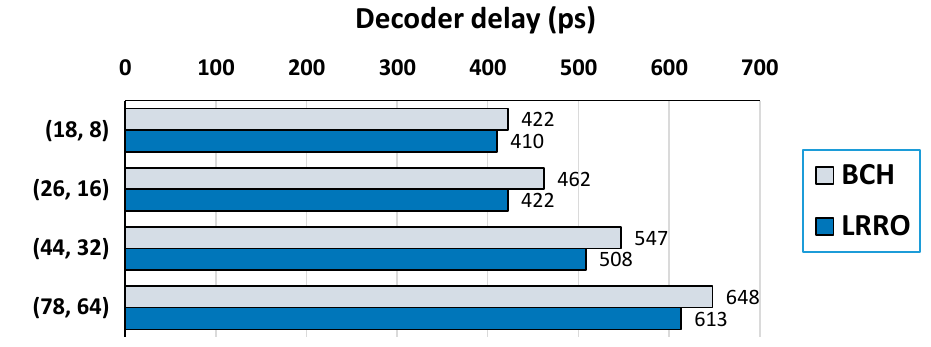
Figure 8. Propagation delay of the decoder circuits (in ps).